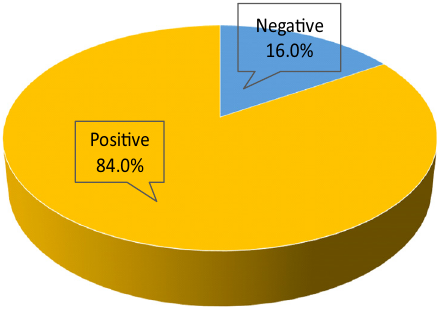
Figure 4: Proportion of positively and negatively concluded EIA applications of mining sector.